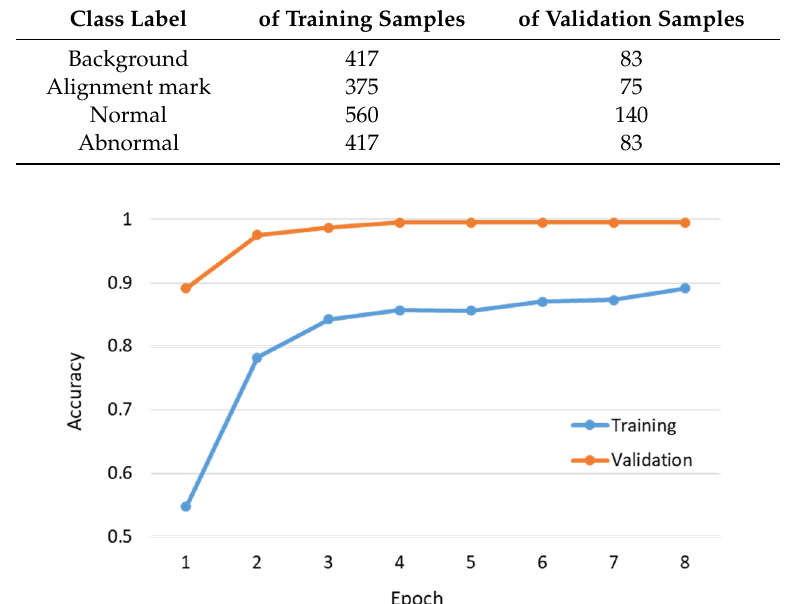
Table 4. Data distribution in Dataset-I.